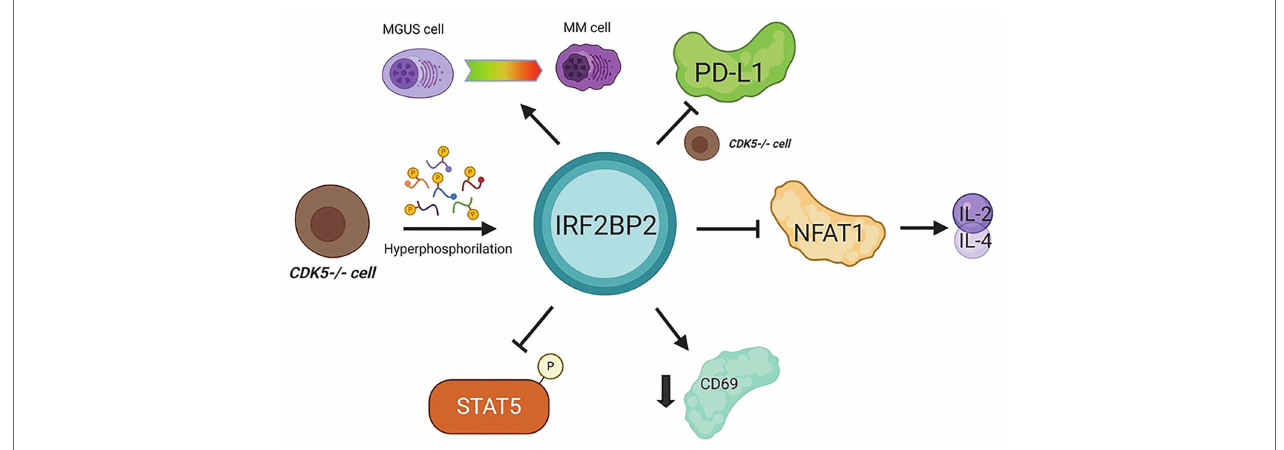
FIGURE 2 | Interferon regulatory factor 2-binding protein 2 in cancer immunomodulation. IRF2BP2 was described as being involved in monoclonal gammopathy of undetermined significance (MGUS) transformation to multiple myeloma (MM) cells. When CDK5 is depleted programmed death-ligand 1 (PD-L1) is inhibited. In CD4 T lymphocytes, IRF2BP2 is associated with restraining the IL-2 and IL-4 transcription mediated by NFAT1, decreasing the CD69 marker levels and inhibiting STAT5 phosphorylation. CDK5 depletion leads to IRF2BP2 hyperphosphorylation. MGUS, monoclonal gammopathy of undetermined significance; MM, multiple